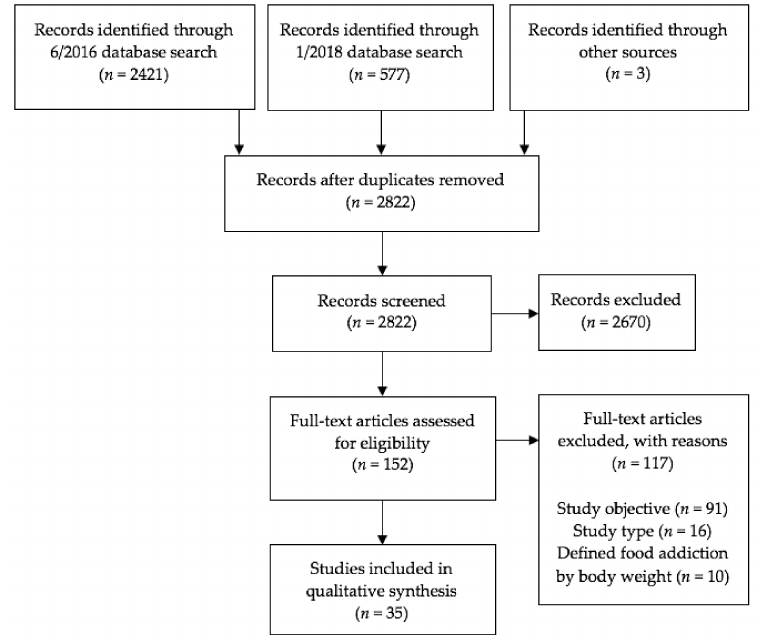
Figure 1. Study selection flow diagram, presented according to the Preferred Reporting Items for Systematic Reviews and Meta-Analyses (PRISMA) statement